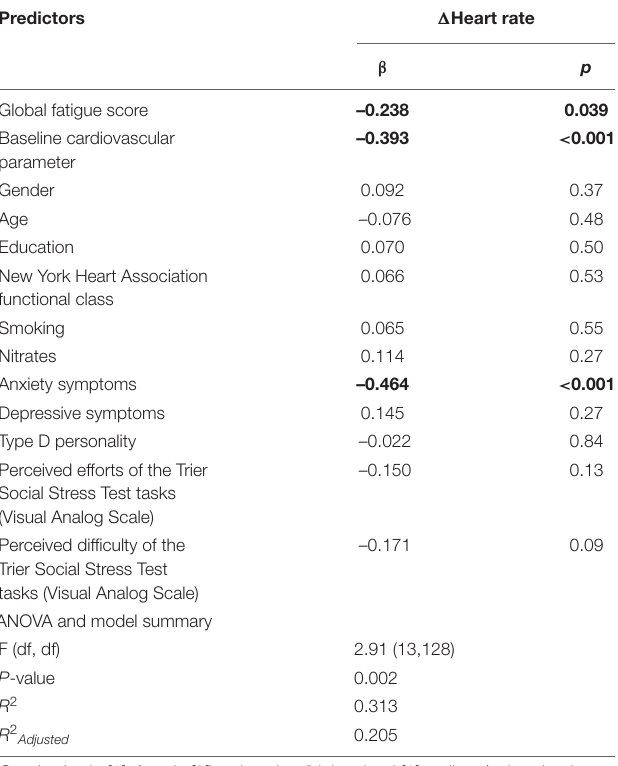
TABLE 5 | Multivariable Linear Regression model, examining global fatigue score associations with cardiovascular reactivity during Trier Social Stress Test (TSST) anticipatory stress (task instruction), while controlling for possible covariates.